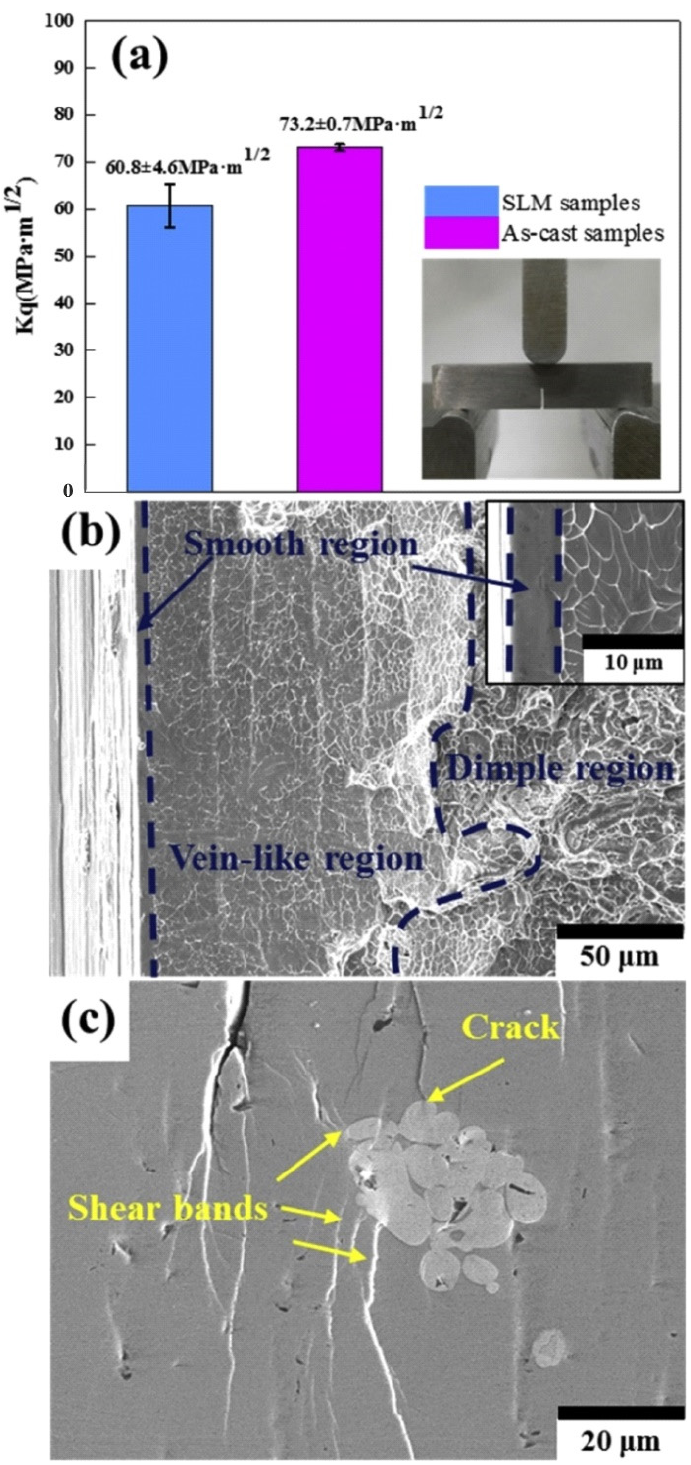
Figure 47. ( a ) Comparison of the notch toughness, K q , of LPBF and an as-cast samples, ( b ) fracture surface of the LPBF sample after failure, and ( c ) crack-arrest by the ductile Ta phase. Reproduced from [46], with permission from Elsevier, 2021.